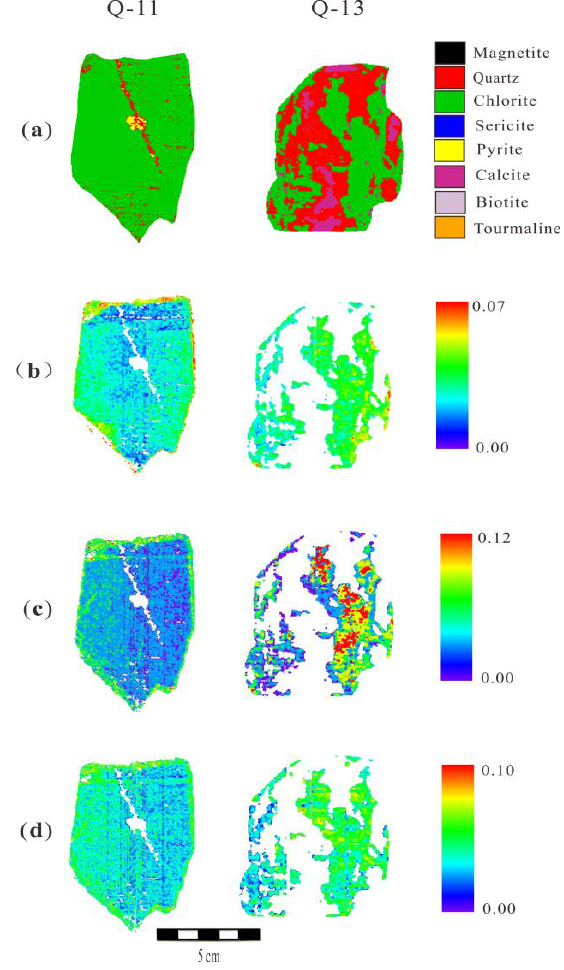
Figure 19. Results of the absorption depth of chlorite: ( a ) mineral map; ( b ) absorption depth of OH; ( c ) absorption depth of Fe-OH; ( d ) absorption depth of Mg-OH.